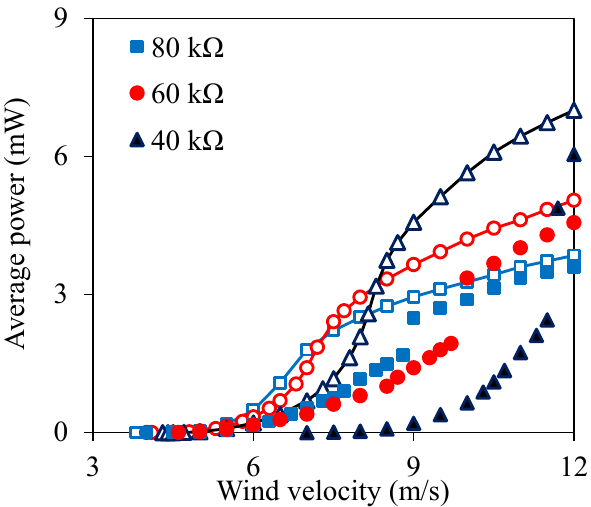
Figure 11. Variation of the average (RMS) power with wind velocity for different external load resistances (solid symbols: measured; lines with empty symbols: simulated).